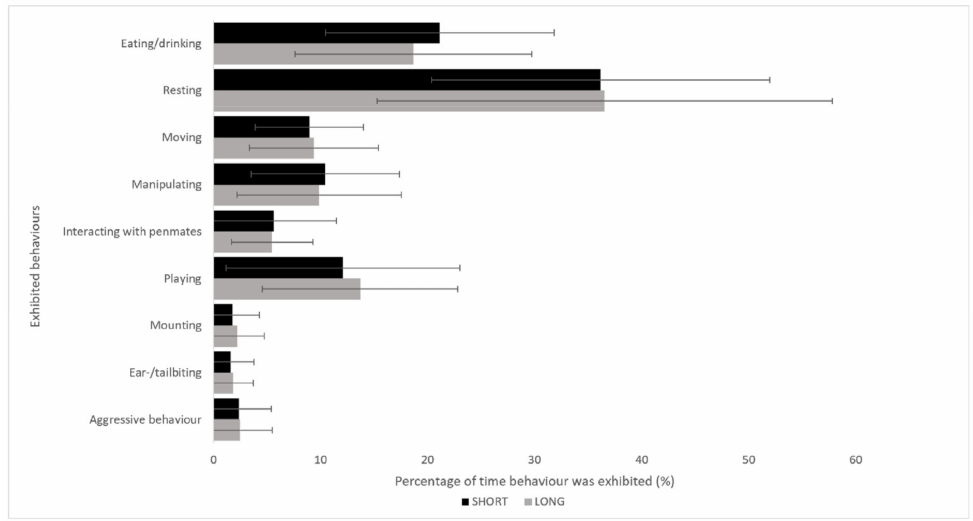
Figure 5. Behavioural parameters of SHORT photoperiod piglets (black, 8 h light and 16 h dark) compared to LONG photoperiod piglets (grey, 16 h light and 8 h dark). This graph represents the mean values for the times (percentage) that the behaviour was observed over the different scoring timeframes. The findings were not significant between treatments ( p > 0.05). Whiskers represent the standard error of each mean